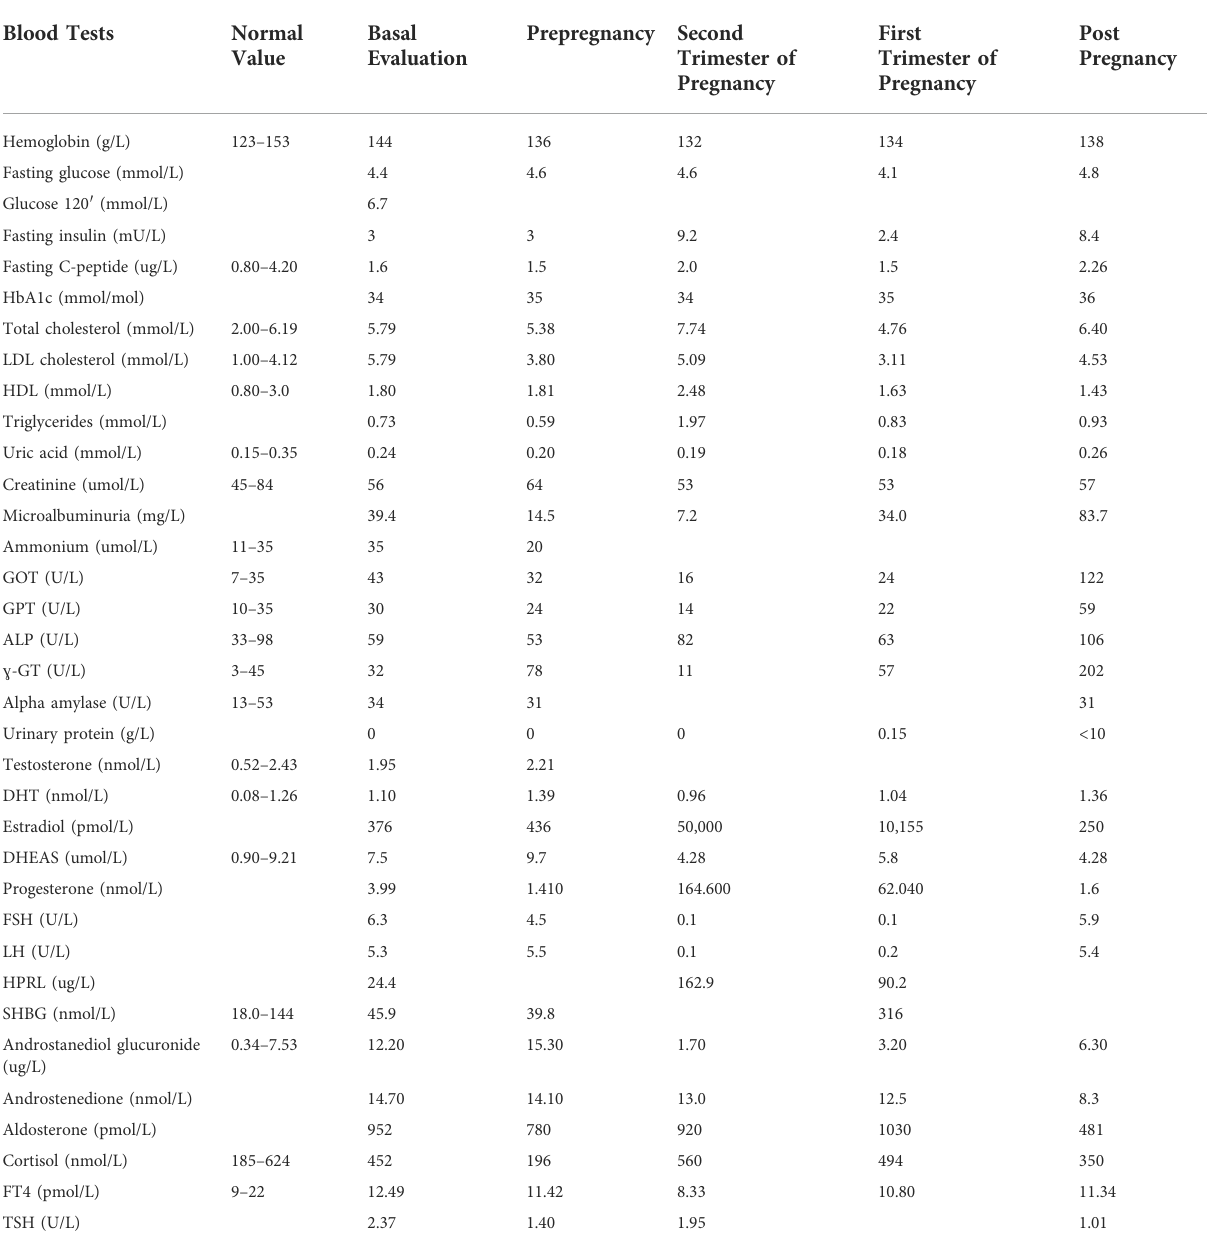
TABLE 1 Biochemical, metabolic, and hormonal test